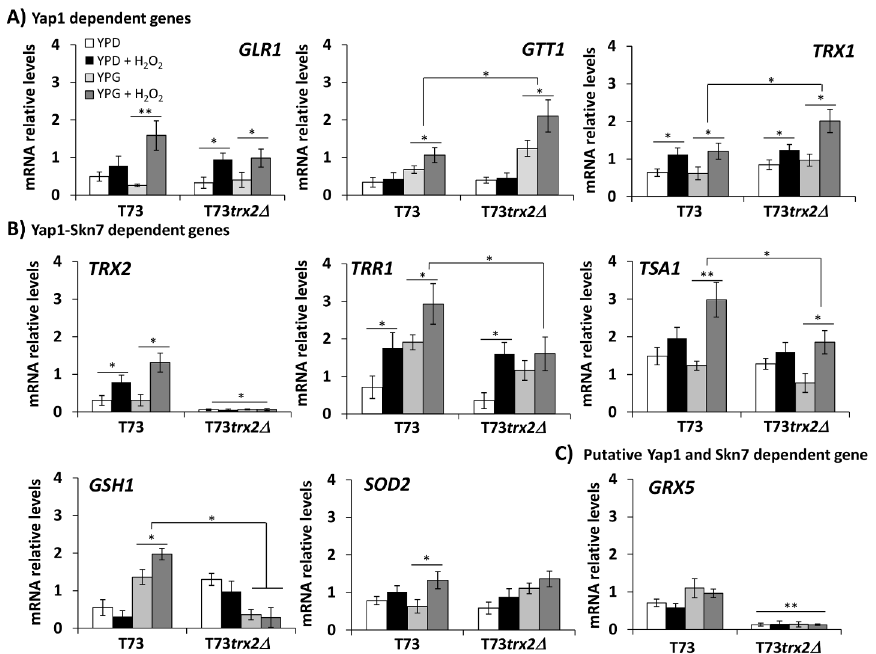
Figure 2. Antioxidant gene expression levels in strains T73 and T73 trx2∆ cultured in YPD or YPG medium to the mid-log phase and treated with 5 mM H O for 60 min. The relative expression levels of each antioxidant gene were quantified from the 2 2 Northern image analysis using the Image Gauge software (FujiFilm, USA). The data for each gene were normalized to the rRNA levels. Experiments were carried out in triplicate and the error bars corresponding to SD are shown. Statistical analyses were performed using a Student´s t -test between samples in the same growth media, YPD or YPG (* p< 0.05, ** p< 0.01). The Yap1p and the Yap1p-Skn7p-dependent gene groups were formed according to the previously described information [21, 22, 43] and from